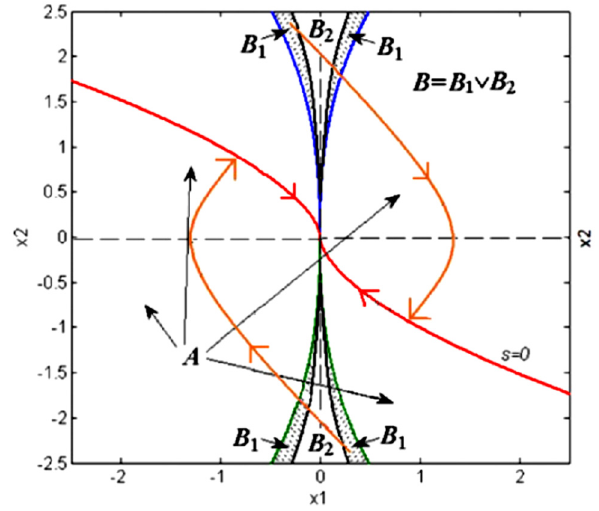
2 u = 5 p = s ). Reprinted with permission